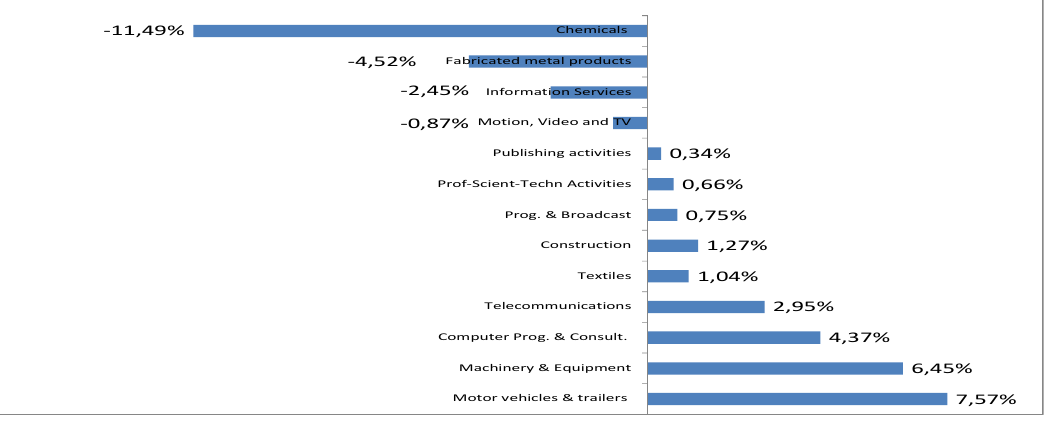
Graph 1: Change in Time of Concentration by Sector (Standard Deviation of Workers amongst Areas), Per cent in 2011- 2000.